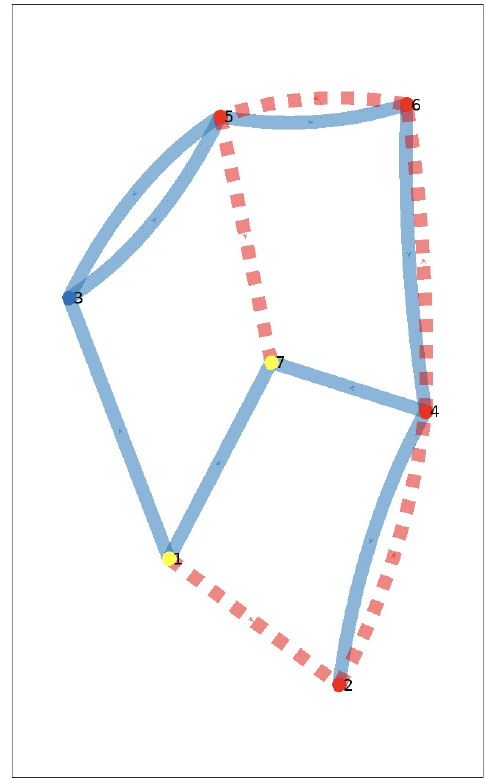
Figure 6. The optimal path (in red) corresponding to Case 3.